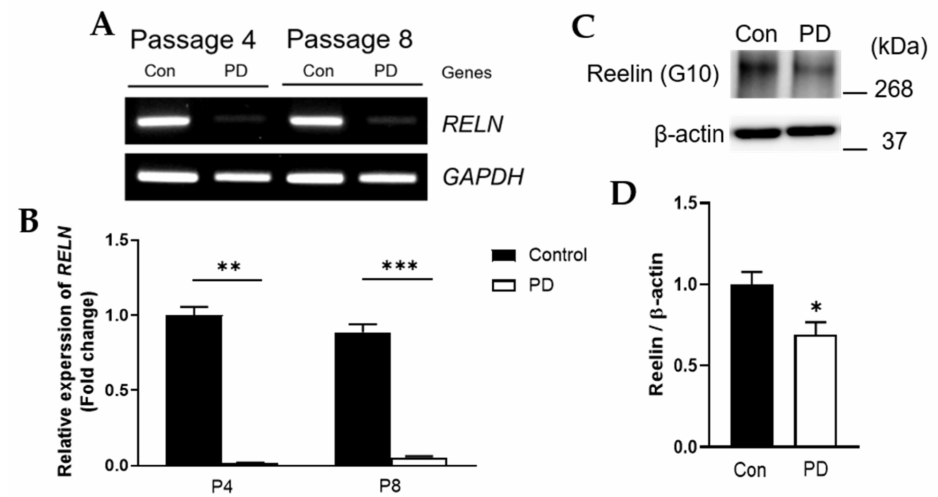
Figure 4. Validation of extracellular matrix (ECM)-related adhesion molecule RELN mRNA and Reelin protein levels. ( A , C ) Conformation of amplification using specific primer for RELN by RT-PCR ( A ) and Reelin protein by Western blot ( C ). ( B , D ) Quantifications of relative RELN expression by qRT-PCR ( B ) and Reelin protein level by Western blot ( D ). n = 3 ( A , B ) and n = 4 ( C , D ) for each group. Mean ± S.E.M. Student’s t -test, * p < 0.05, ** p < 0.01, *** p < 0.001. Parkinson’s disease, PD; Con,